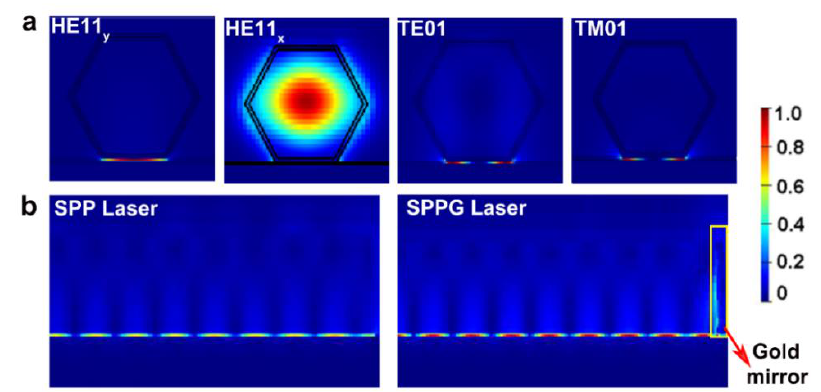
Figure 4. ( a ) The lateral electric field distribution of modes in SPP laser. ( b ) The profile of the propagating HE11 y mode of SPP and SPPG laser near the NW output end. The diameter is 100 nm.